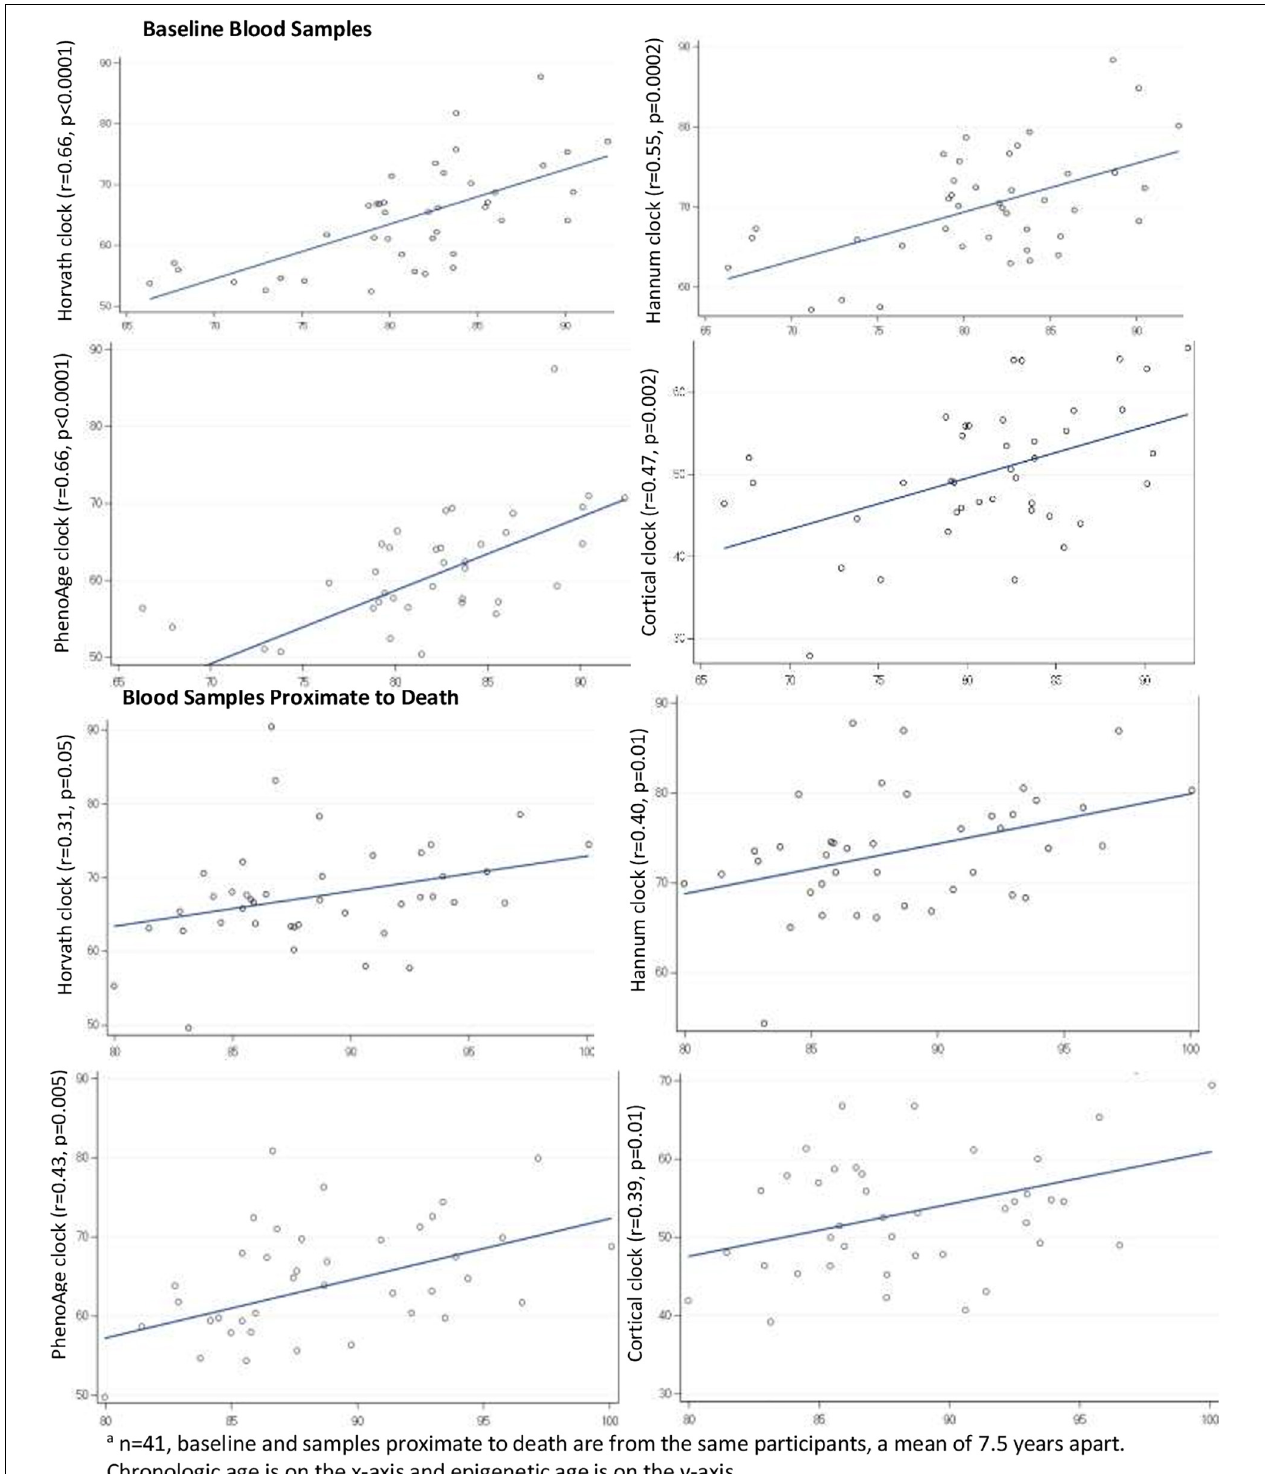
FIGURE 2 | Pearson correlations of epigenetic age to chronologic age in blood samples a .